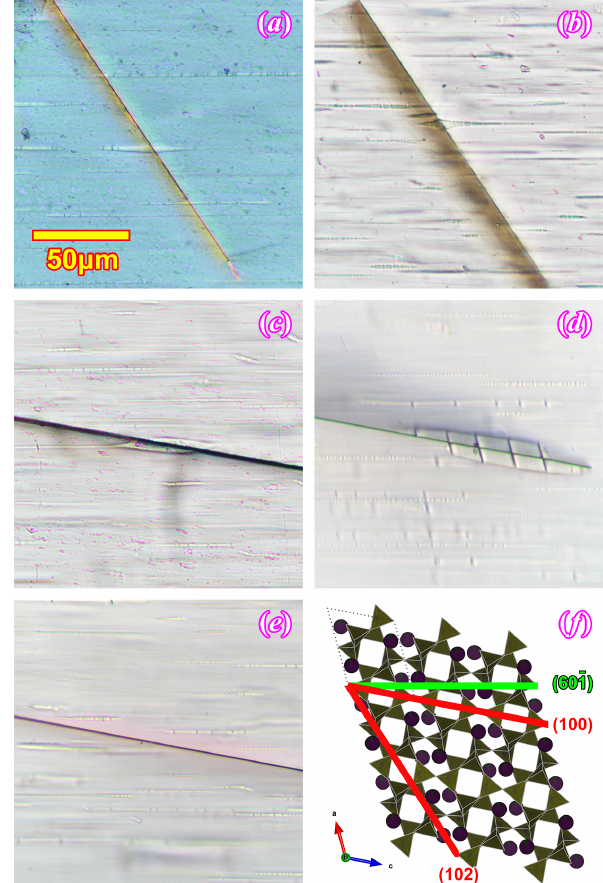
Figure 5. The film inclusions in the (010) sections of the RLS under optical microscope. Panel (a) is taken between crossed polarizers, (b) and (c) are under plane polarized light, and (d) and (e) are un- der focused plane polarized light with thicker sections. The spatial relationship between the orthoclase structure, the oligoclase spin- dle (subparallel to ( 601 ) ) and the two iron oxide film orientations ((100) and (102)) is illustrated in (f)